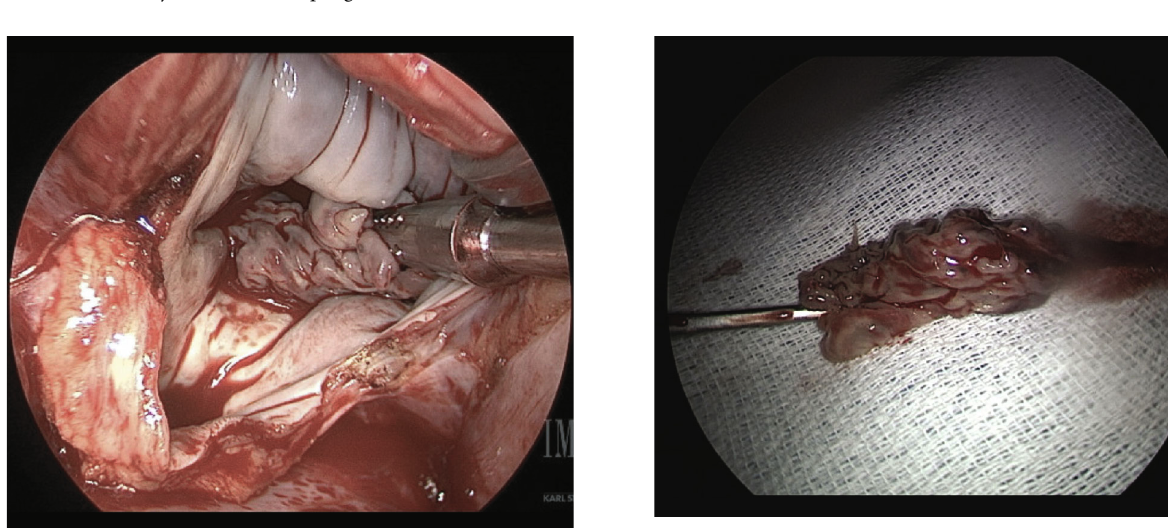
Figure 1: Cross-sectional image of CT scan with IV contrast demonstrating the atrio-esophageal defect. LA: left atrium; Ao: Aorta; arrow: extraluminal air adjacent to the esophagus.